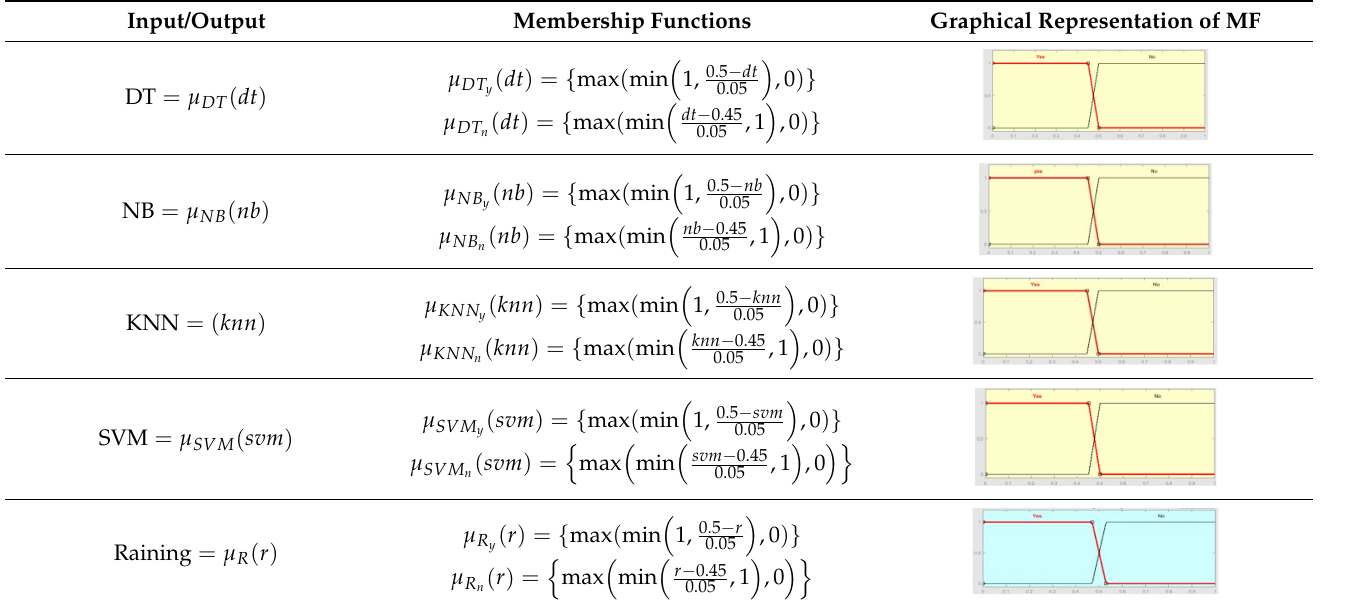
Table 2. Graphical representation of MF.